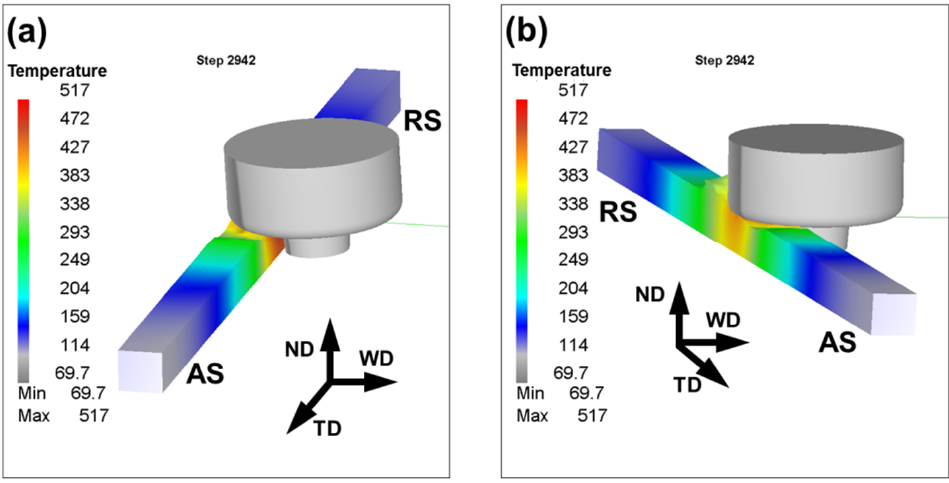
Figure 3. A schematic showing the analyzed sections of friction stir weld: ( a ) the section directly behind the tool probe, and ( b ) the section directly behind the shoulder edge. Note: In the figure, the simulated 3-D temperature distributions for 1100–125 weld are shown. AS and RS are advancing side and retreating side, respectively; WD, ND and TD are welding direction, normal direction, and transverse direction,